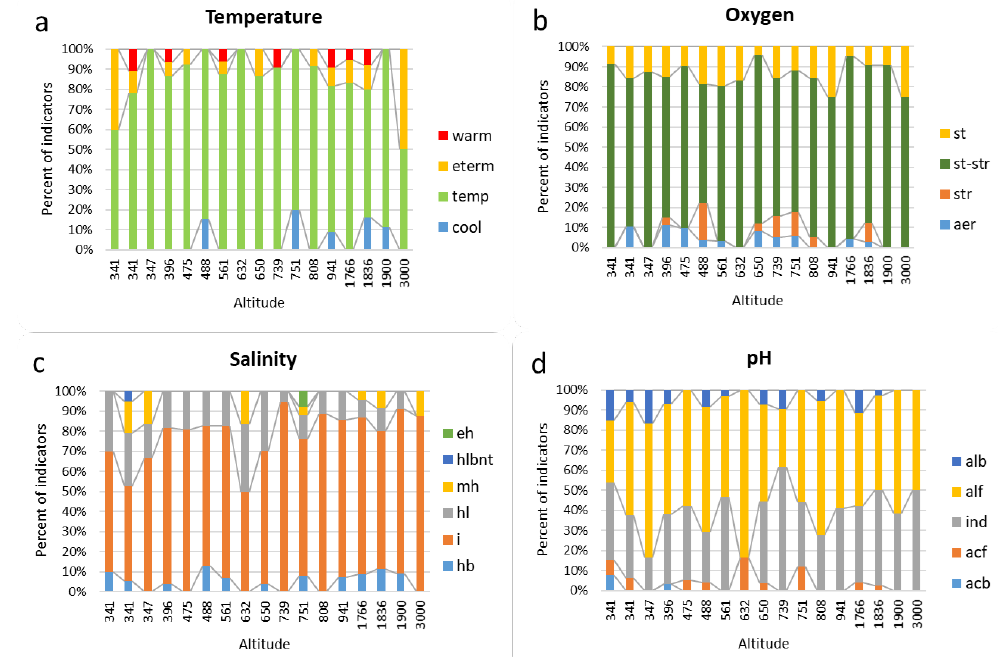
Figure 7. Dynamics of indicator species percentage in the communities over the study sites: ( a ) tem- perature indicators (cool — cool water, temp — temperate temperature, eterm — eurythermic, warm — warm water inhabitants); ( b ) oxygenation and water moving indicators (st — standing water, st – str — low streaming water, str — streaming water, aer — aerophiles); ( c ) salinity indicators (i — oligo- halobes – indifferent, hl — halophiles, hb — halophobes, mh — masohalobes, hlbnt — halobiontes, eh — euhalobes); ( d ) water pH indicators (alf — alkaliphiles, ind — indifferents; acf — acidophiles, alb — al- kalibiontes, acb — acidobiontes).